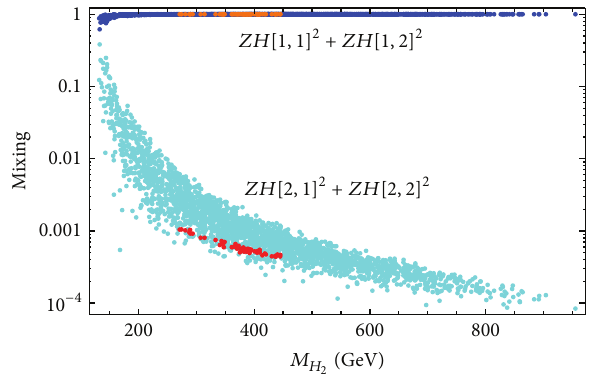
Figure 4: Mixing between Higgs boson mass eigenstates (blue- orange: 𝐻 1 , cyan-red: 𝐻 2 ) and scalar doublet fields, as a function . 𝑍𝐻[𝑖, 𝑗] is the scalar mixing matrix. Orange/red points are of 𝑀 𝐻 2 the subset corresponding to BR (𝐻 2 → ̃ ] 𝑆 ̃ ] 𝑆 ) > 90%.